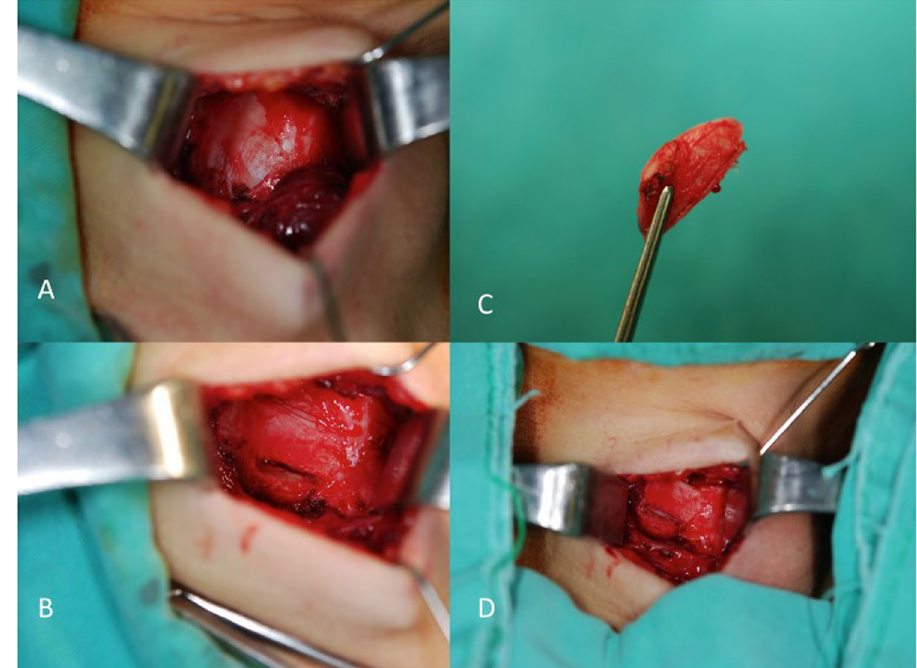
Figure 1. Illustration of surgical procedure. ( A ) Lesion side of the thyroid cartilage was exposed. ( B ) Creation of a narrow thyroplasty window. ( C ) A lunar-shaped cartilage graft. ( D ) The graft was inserted and then pressed into the